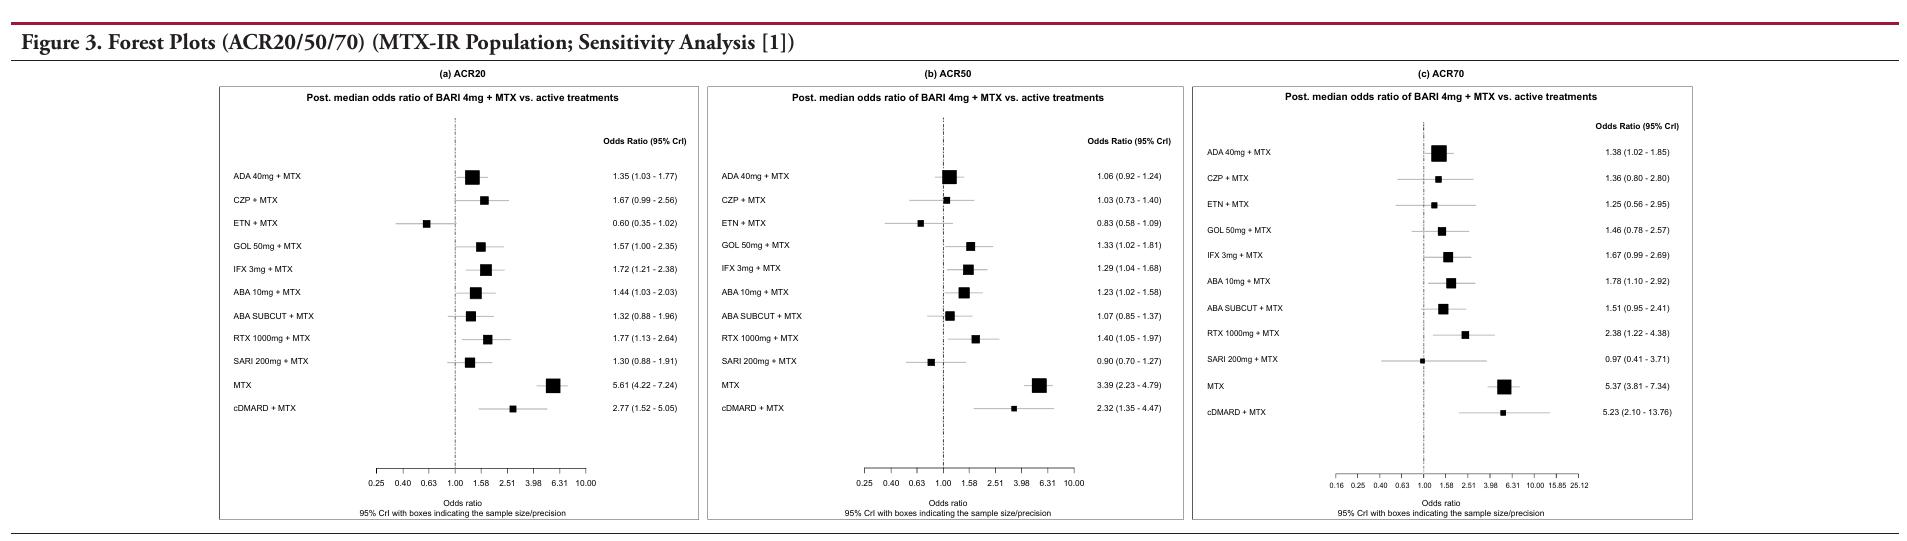
Odds ratios (ORs) presented refer to BARI 4 mg + MTX vs active treatments. Therefore, ORs >1 are in favor of BARI 4 mg + MTX, whereas ORs <1 are in favor of the comparator. Sensitivity analysis (1): Baseline-risk adjustment (19 trials for ACR20 and 18 trials for